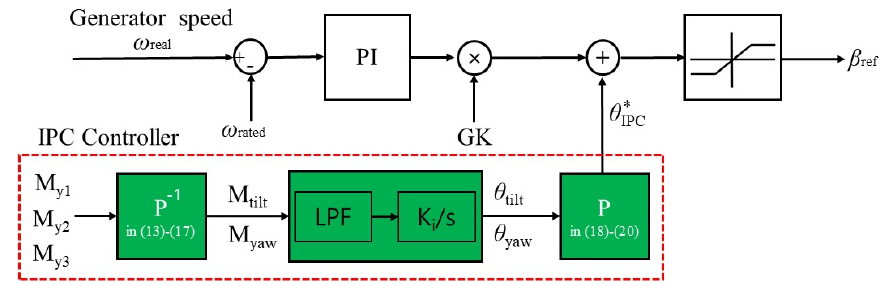
Figure 4. IPC pitch control algorithm configuration diagram.